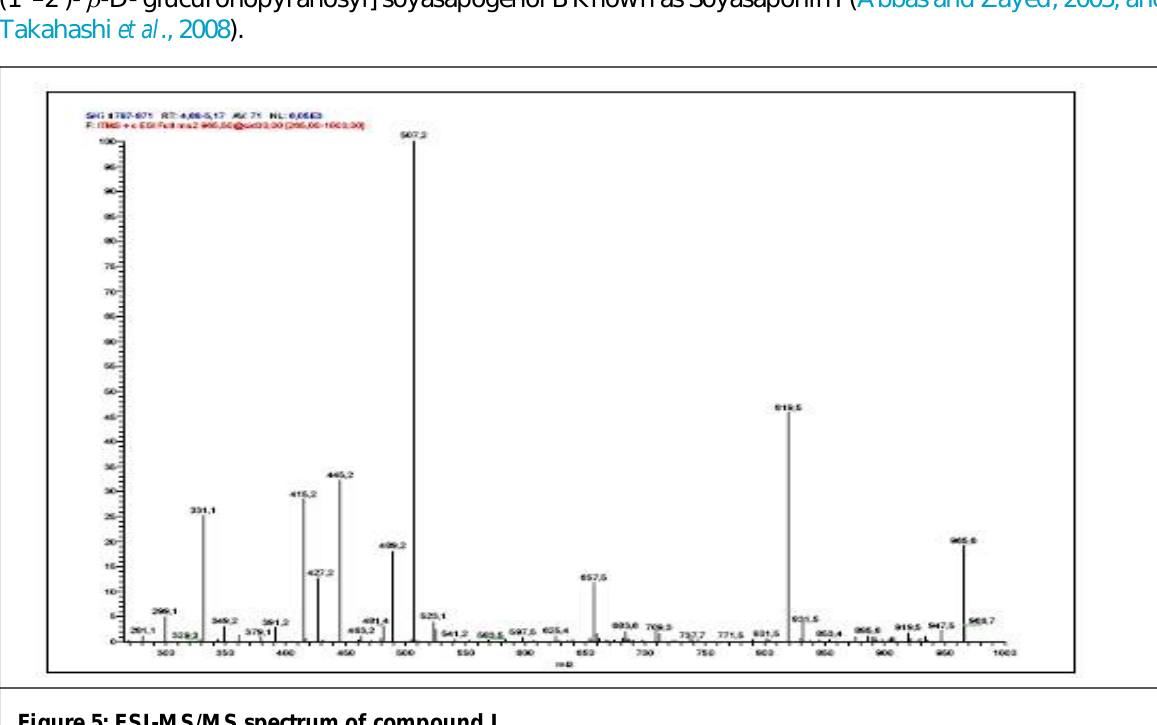
Figure 5: ESI-MS/MS spectrum of compound